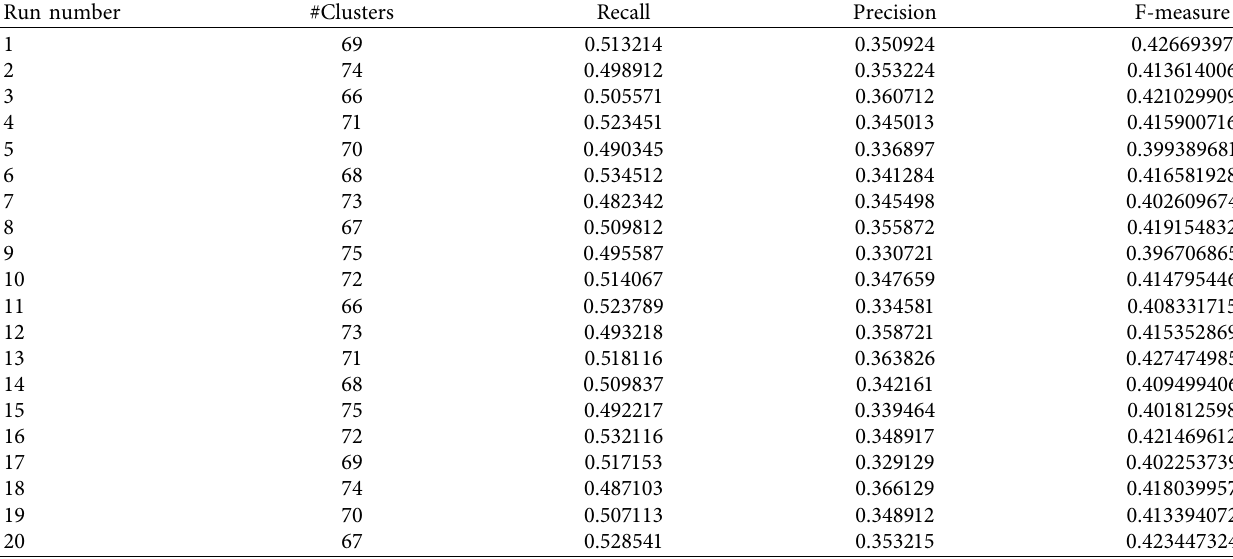
Table 4: Collins data sample clustering results in 20 independent runs (MIPS complex reference).